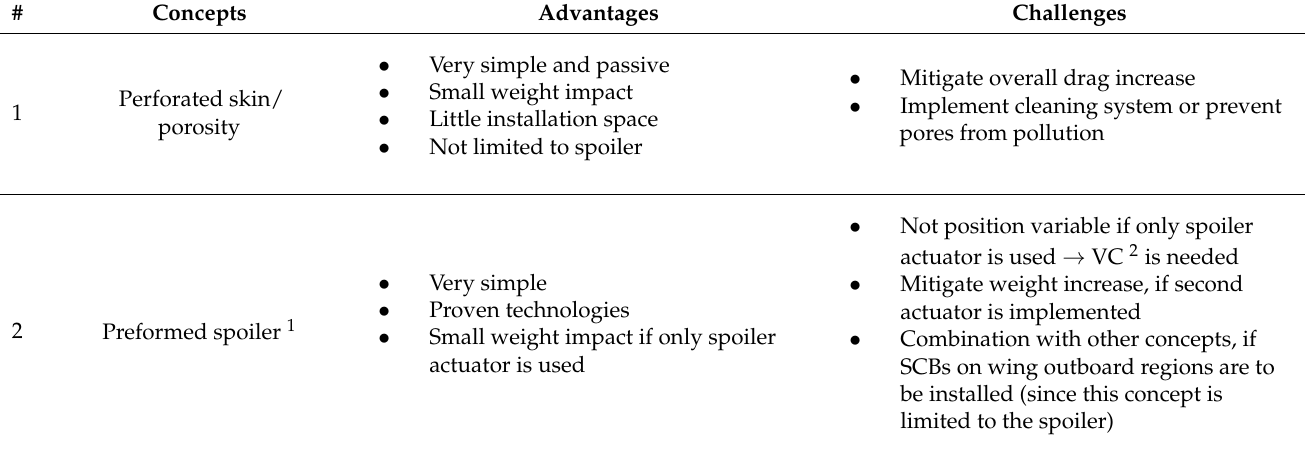
Table 1. Summary of shock control concepts including advantages, disadvantages and